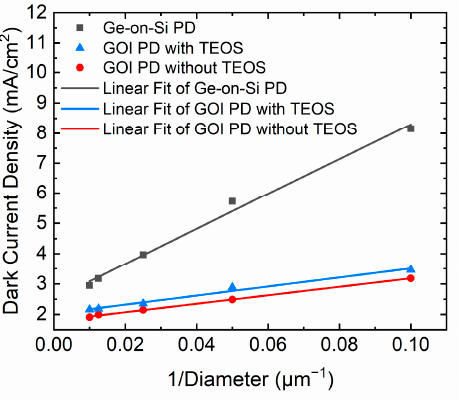
Figure 3. Dark currents of ( a ) GOI detectors with diameters of 10, 20, 40, 60, 80, and 100 μ m, and ( b ) detectors on three types of substrates with diameters of 10 and 80 μ m.